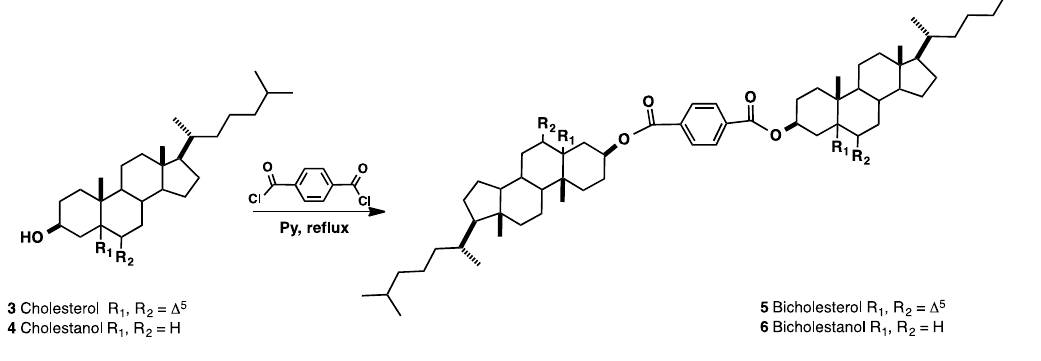
Table 1. Conditions of reaction to obtain bisteroids derivatives from cholesterol ( 3 ) and diosgenin ( 7a